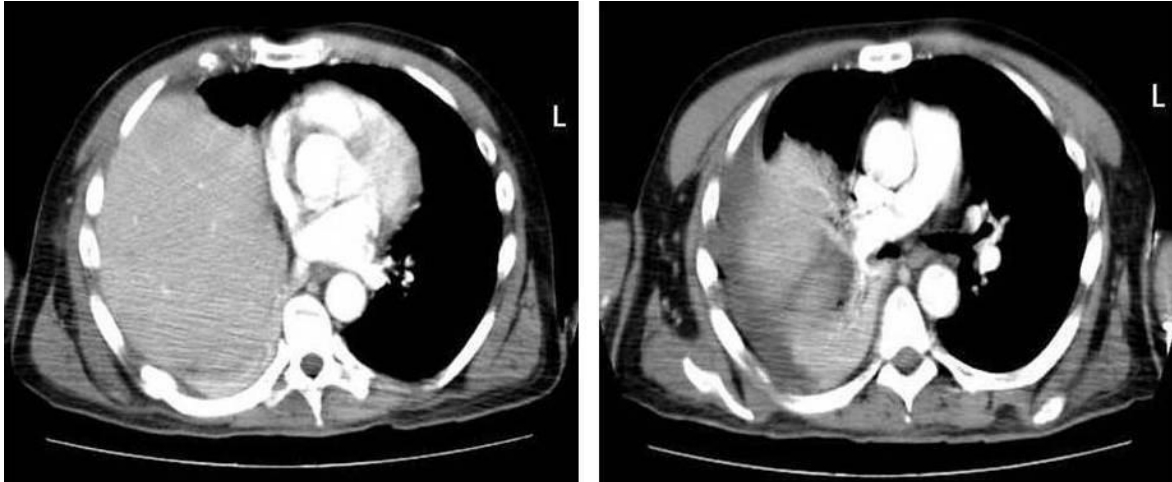
FIGURE 1. CT of the thorax highlights the obliteration of the pleural cavity by the liver and pulmonary parenchyma